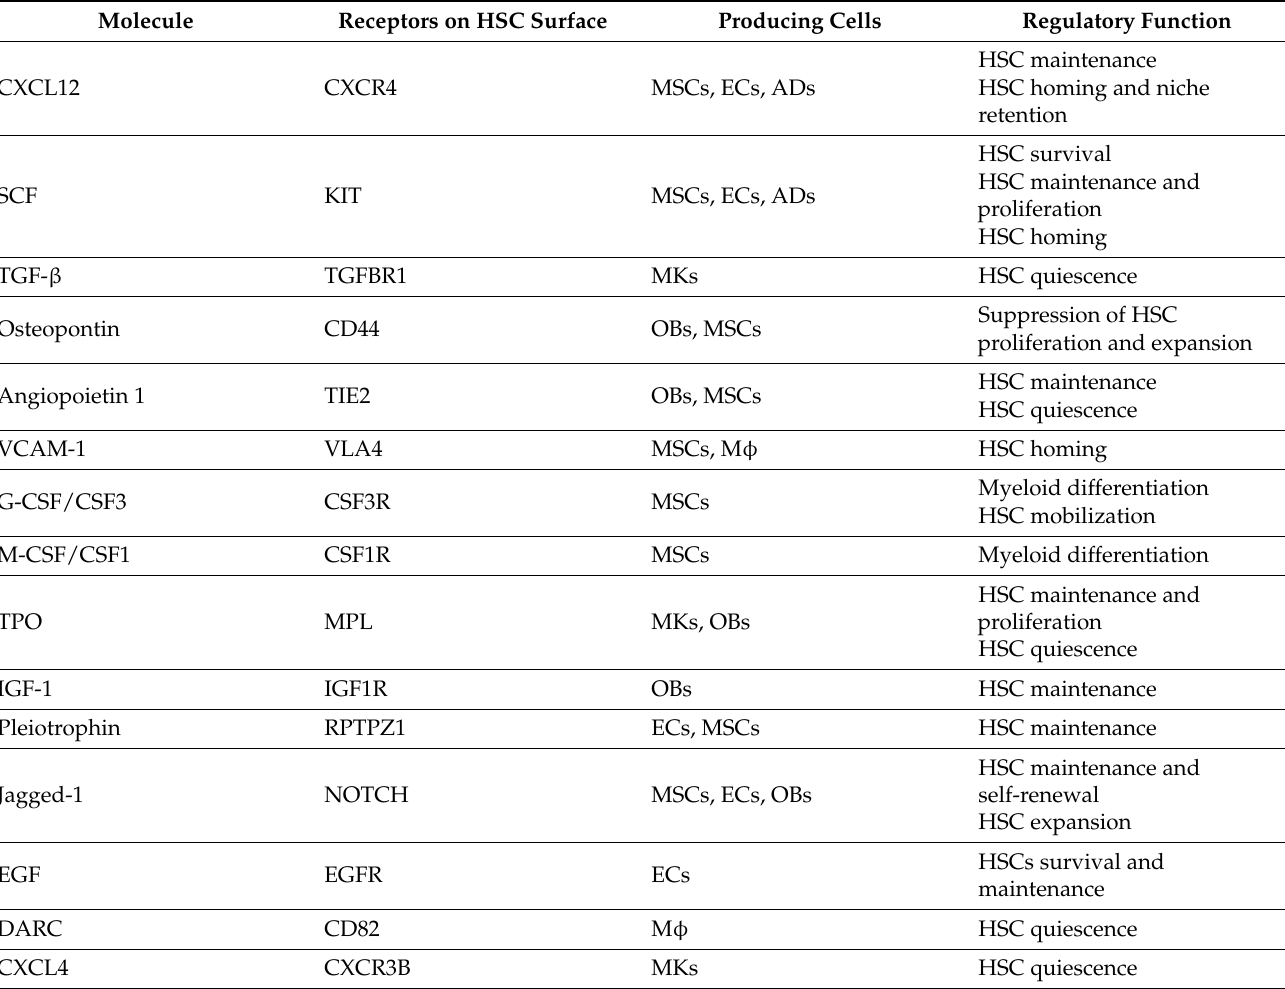
Table 2. Key molecules participating in HSC regulation by BM